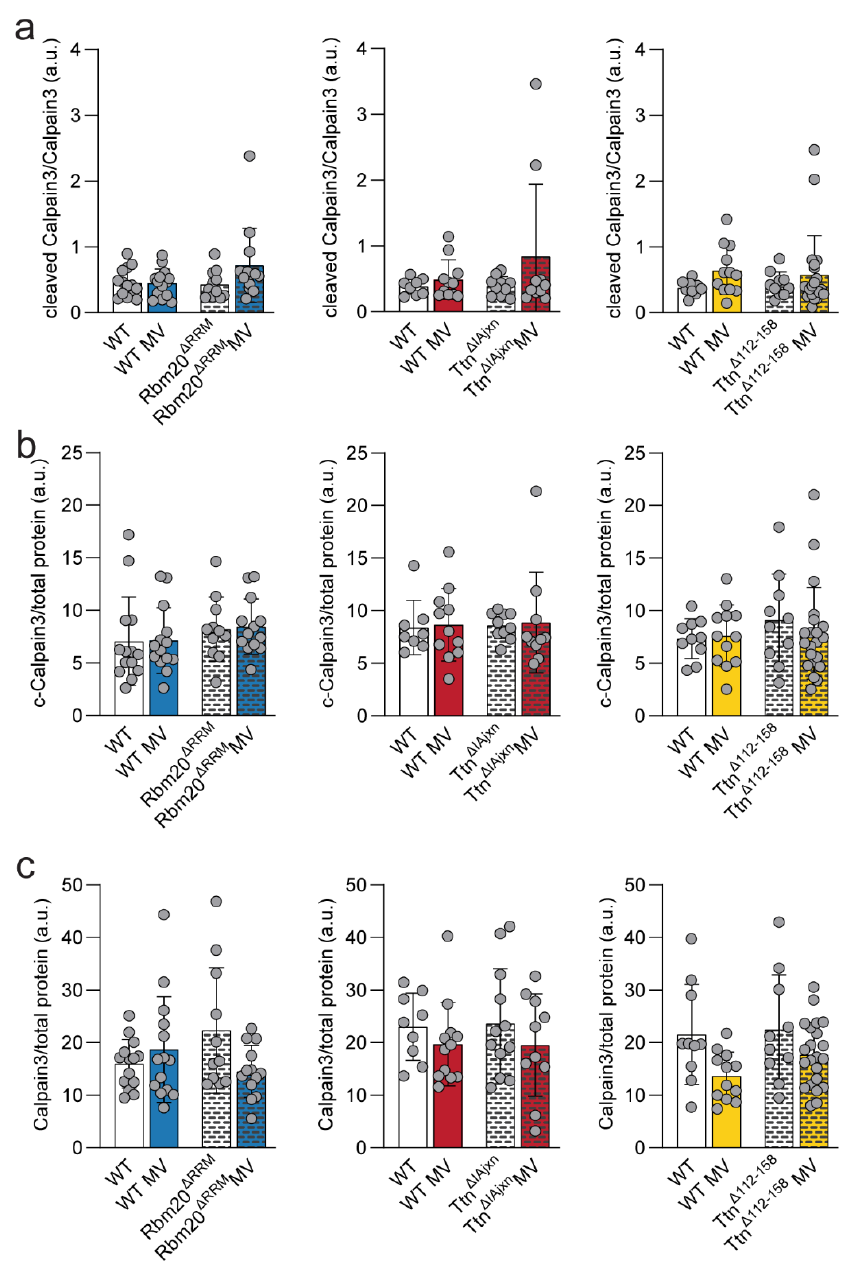
Figure 6. Protein expression levels of autolytic calpain3/calpain3 ratio, cleaved calpain3, and cal- pain3. ( a ) Cleaved calpain/calpain 3 ratios, ( b ) cleaved calpain3, and ( c ) calpain3 protein expression relative to total protein in Rbm20 Δ RRM , Ttn Δ IAjxn and Ttn Δ 112 − 158 respectively. Bars represent mean ± SD. WT = wild type, MV = mechanically ventilated. Each dot represents a single animal and animals are only presented in each graph once.